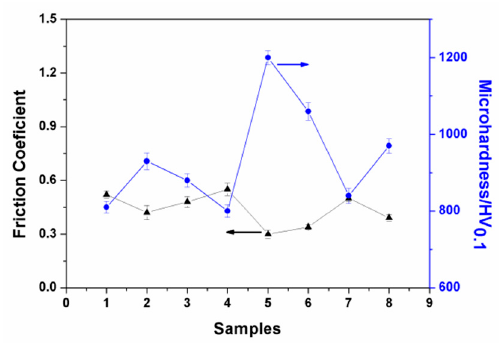
Figure 7. Friction coefficient and microhardness of the ceramic coatings.